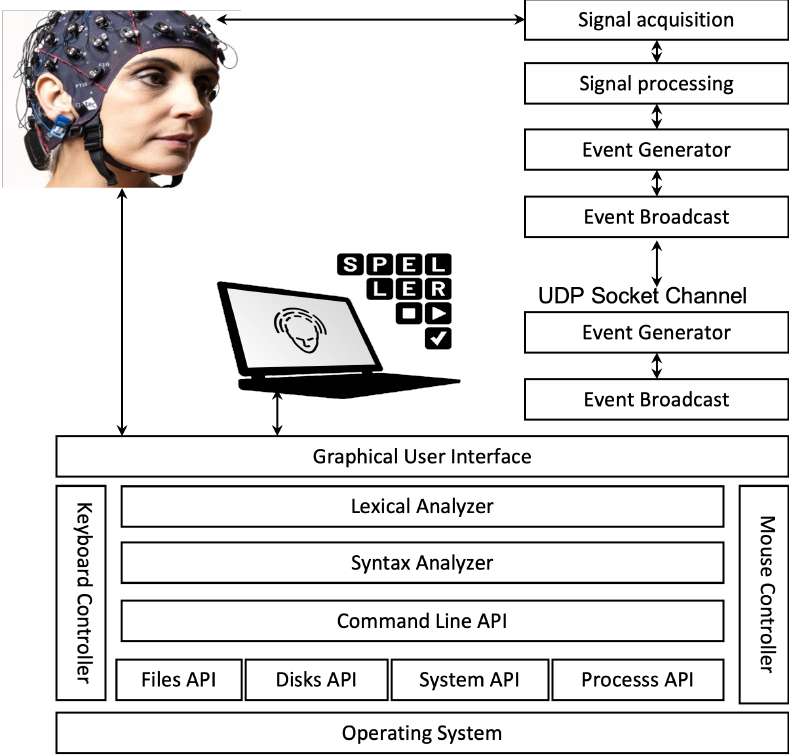
Figure 1. System